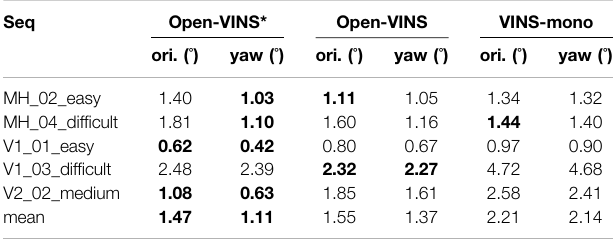
TABLE 2 | Orientation estimation results of different VIO methods. The Open- VINS* method takes the calibrated gyroscope data (produced by our proposed Calib-Net) as the input. Both 3D orientation and yaw estimation results are given in the table. The best results are made in bold. Seq Open-VINS* Open-VINS